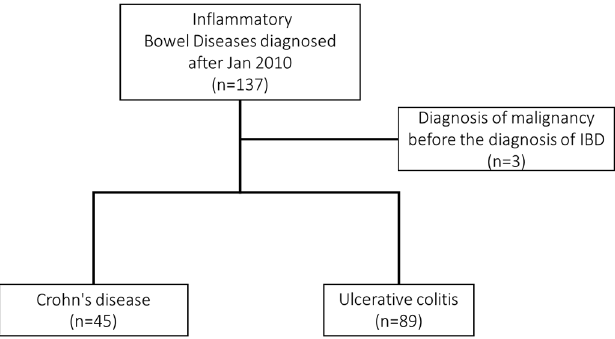
Figure 1. Flow chart of patient enrollment in the present study.